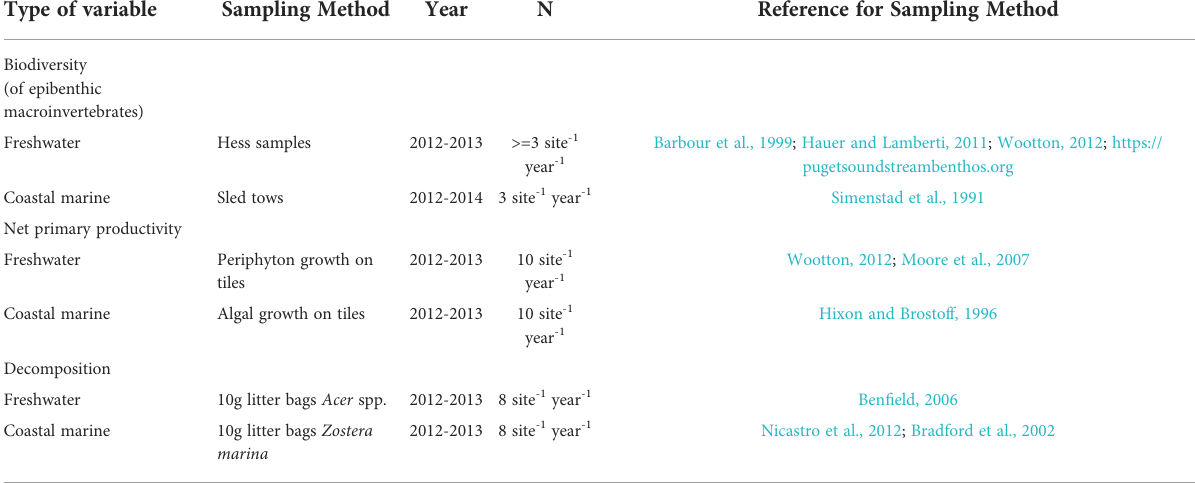
TABLE 2 Description of data types and sampling